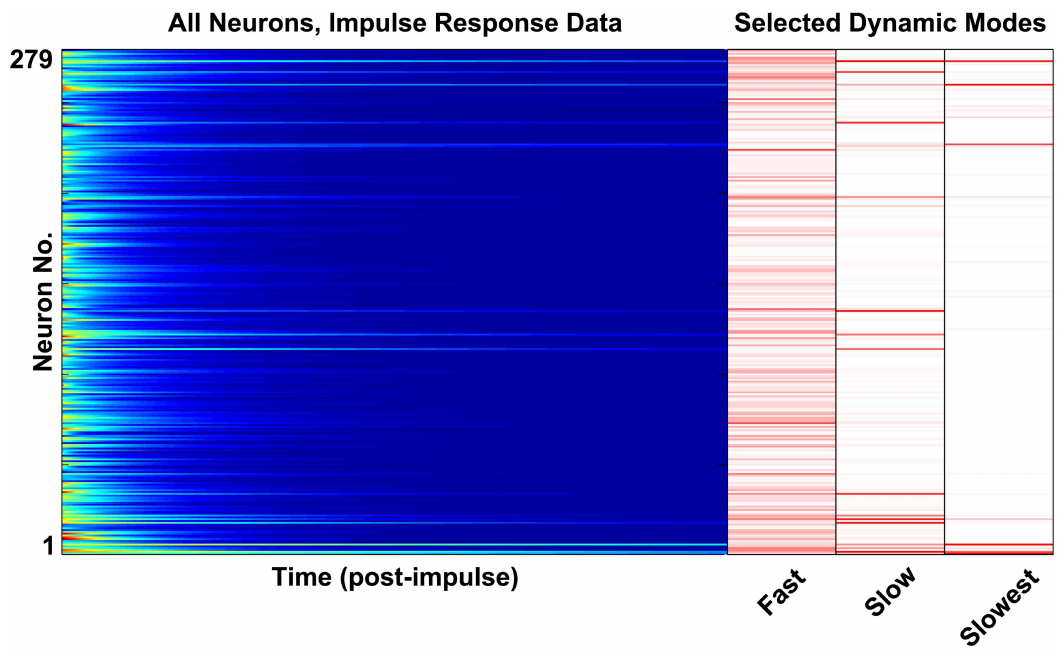
Fig 2. The rasterplot at left plots shows a single trial of neuron voltage responses to a random impulse. The nonlinearnetwork dynamics encode six clusters of dynamicmodes with timescales spanningthree orders of magnitude. In the right panelwe plot a subset of the dynamic modes which we extract from these dynamics (the ϕ vectors calculatedfrom Eq 14). The modes shown are those with the slowest timescales, later referred to as Modes 4, 5 and 6. One can see the modal dynamics within the raster plot (e.g. one can see traces of the “slow” and “slower”modes, each decayingat a different rate).